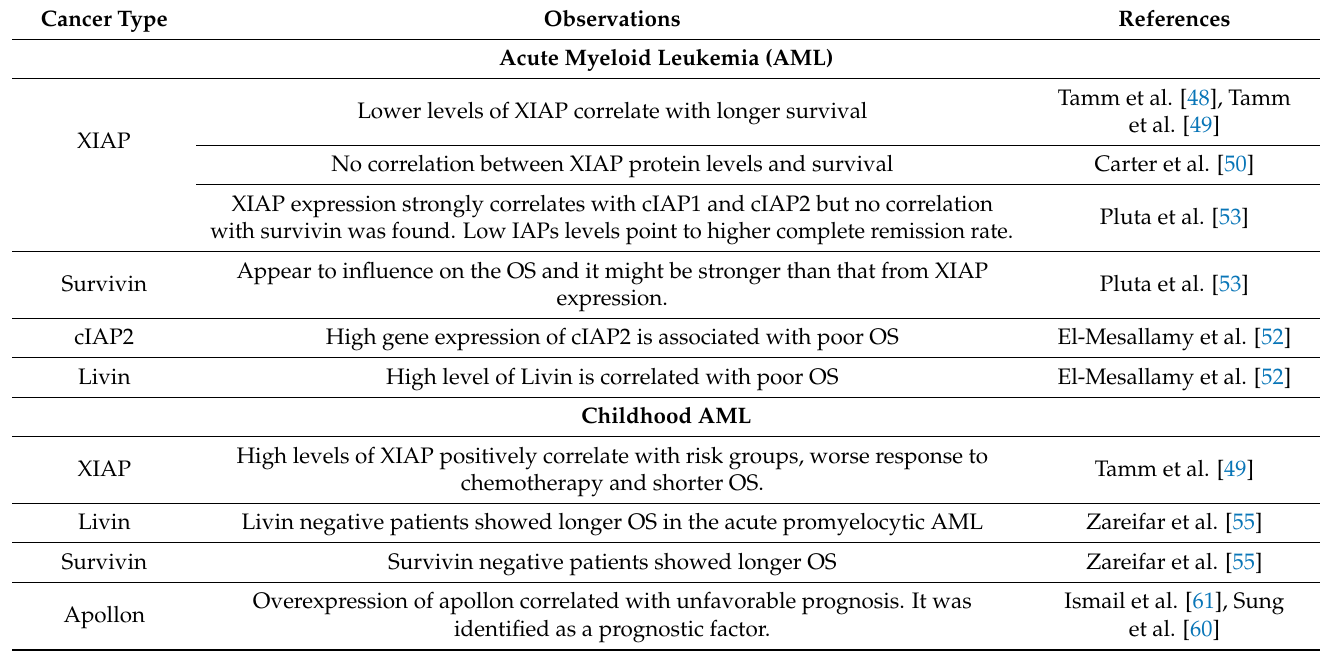
Table 1. IAPs and cancer. Abbreviations: AML, acute myeloid leukemia; CLL, chronic lymphocytic leukemia; CRC, colorectal cancer; FU, fluorouracil; OS; overall